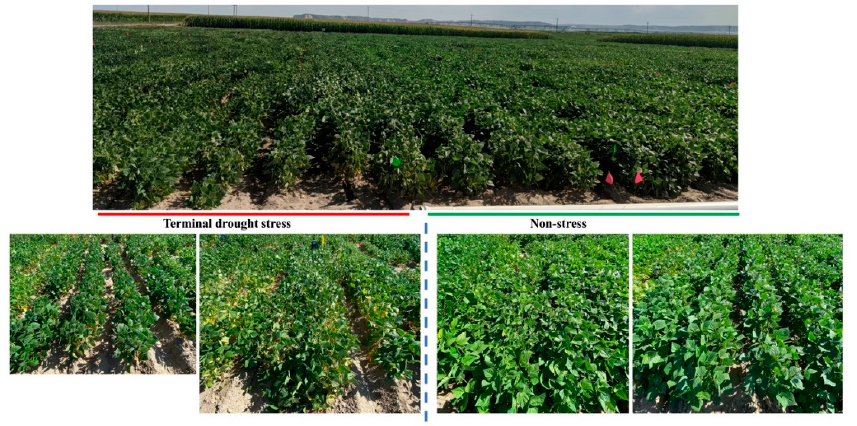
Figure 1. Experiments conducted under stress and non-stress conditions in the